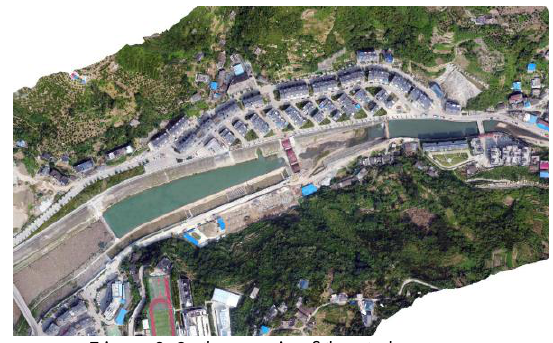
Figure 6. Orthomosaic of the study area